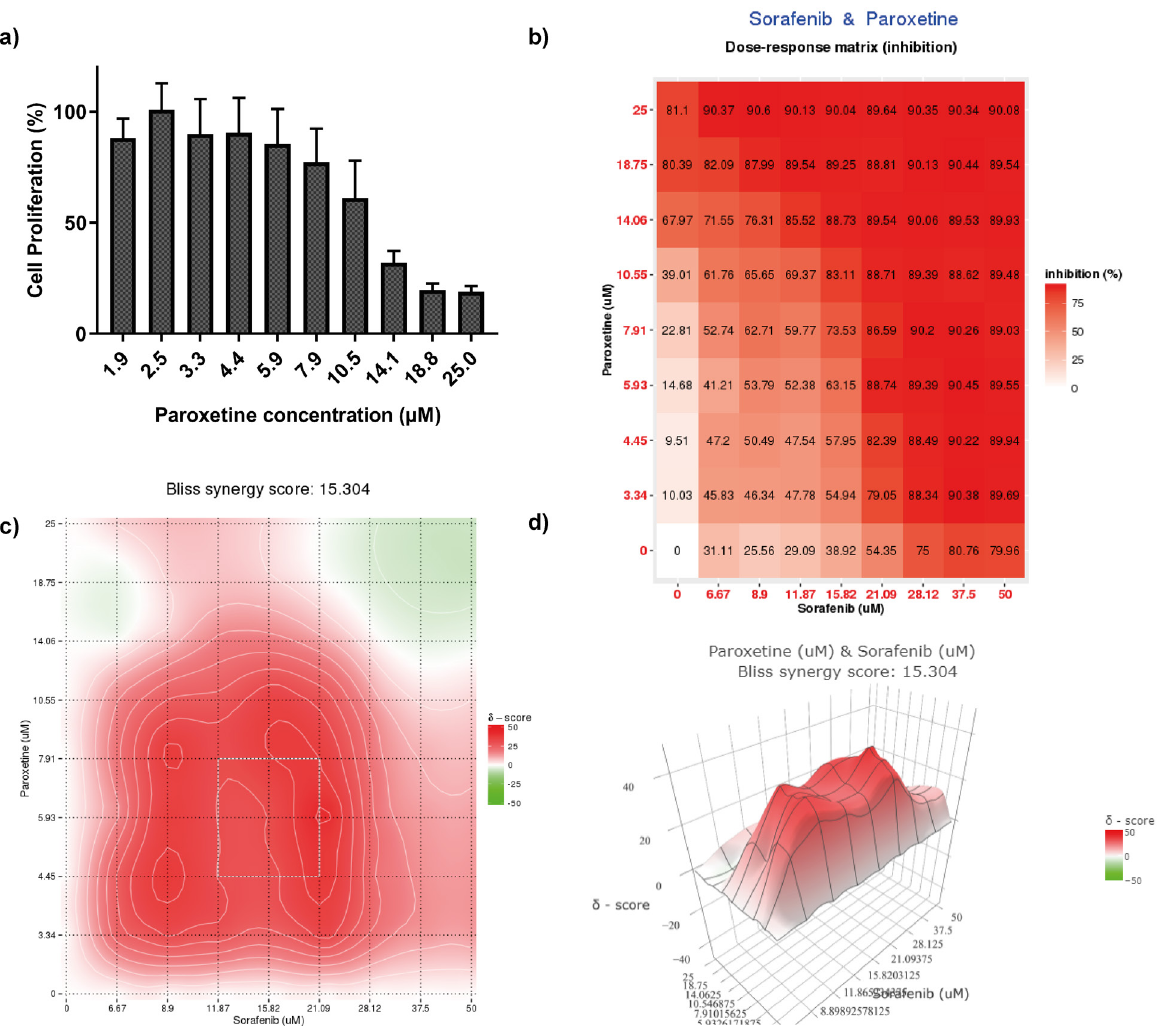
FIGURE 1 - Cytotoxicity of increasing concentrations of paroxetine in HepG2 cells after 24h of treatment (A). Dose-response matrix data demonstrating inhibition of cell proliferation in response to various doses of a paroxetine-sorafenib combination (B). 2D (C) and 3D (D) synergy maps highlighting the synergistic dose regions in red, demonstrating a strong synergism with a Bliss synergy score of